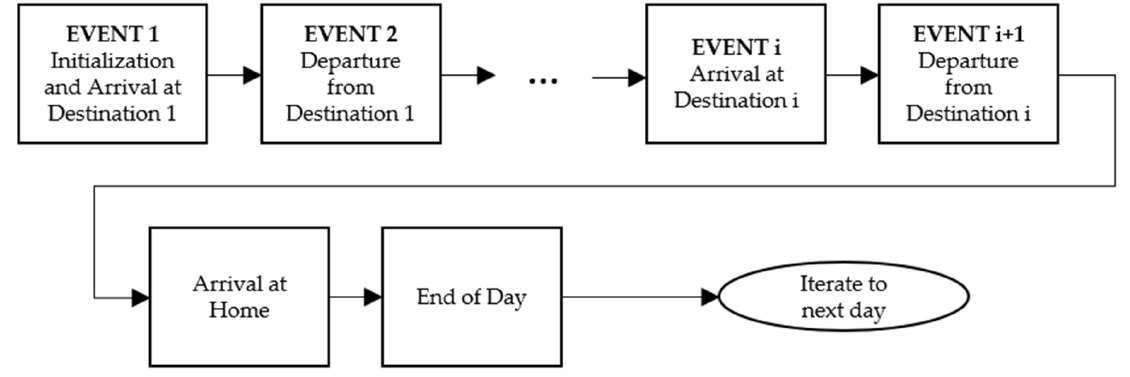
Figure 2. Summary of tasks carried out by the model in each event.